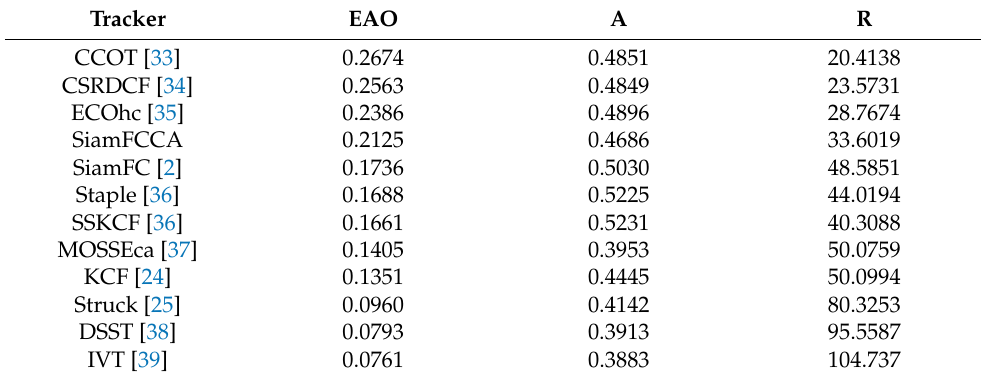
Table 3. The performance comparison of trackers on the VOT